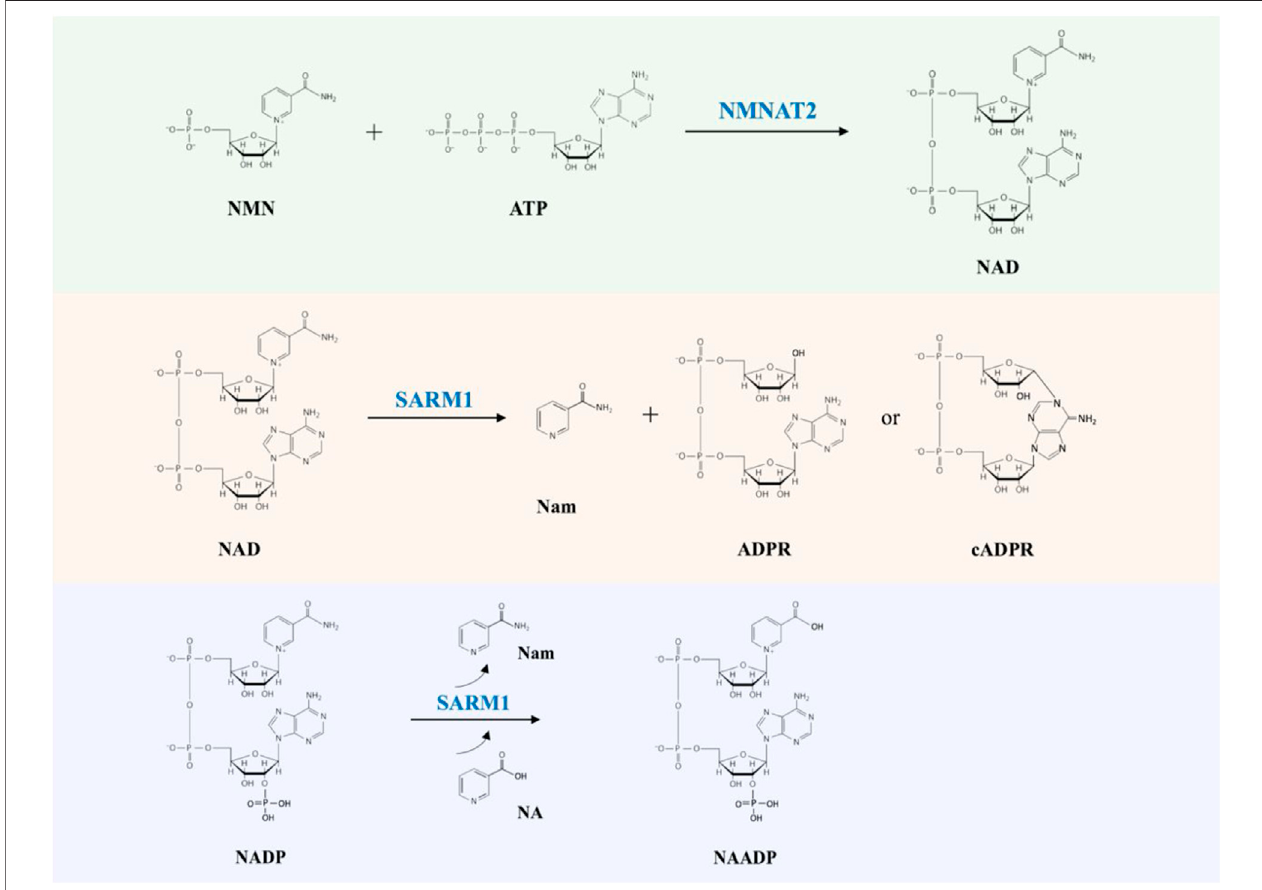
FIGURE 1 | The NMNAT2 and SARM1 catalyzed reactions. NMNAT2 catalyzes the synthesis of NAD from NMN and ATP. SARM1 cleaves NAD into Nam and either ADPR or cADPR; SARM1 catalyzes the exchange of Nam of NADP with NA (nicotinic acid) to produce NAADP (nicotinic acid adenine dinucleotide phosphate).